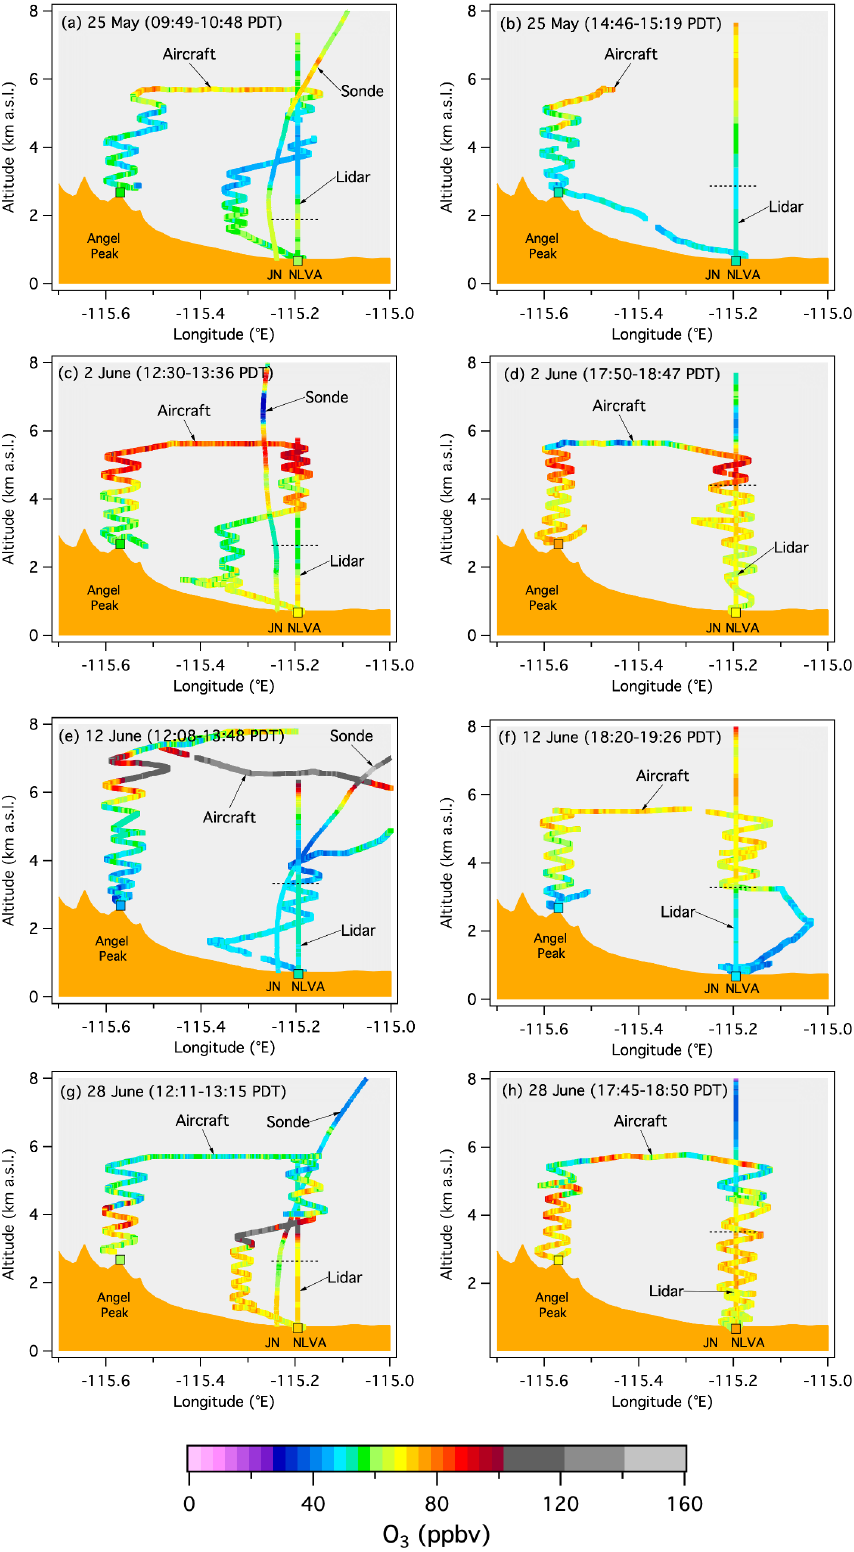
Figure 15. Ozone mixing ratios measured by the lidar, ozonesonde, and aircraft and by the AP, Joe Neal (JN), and NLVA surface monitors during the outgoing (left) and returning (right) flights on (a, b) 25 May, (c, d) 2 June, (e, f) 12 June, and (g, h) 28 June. The dashed horizontal lines show the boundary layer height inferred from the NLVA Doppler lidar